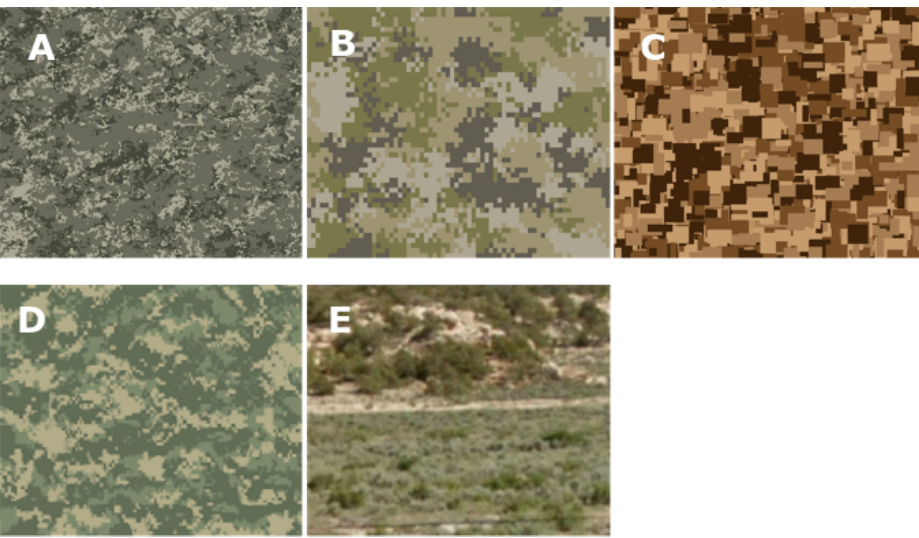
Figure 20. Camouflages analyzed in the steppe area: ( A ) generated with created CammoGenerator , ( B ) generated with Camouflage Generator [15], ( C ) generated with Digital Cammo Generator [16], ( D ) UCP camouflage (Universal Camouflage Pattern) [24], ( E ) tested section of